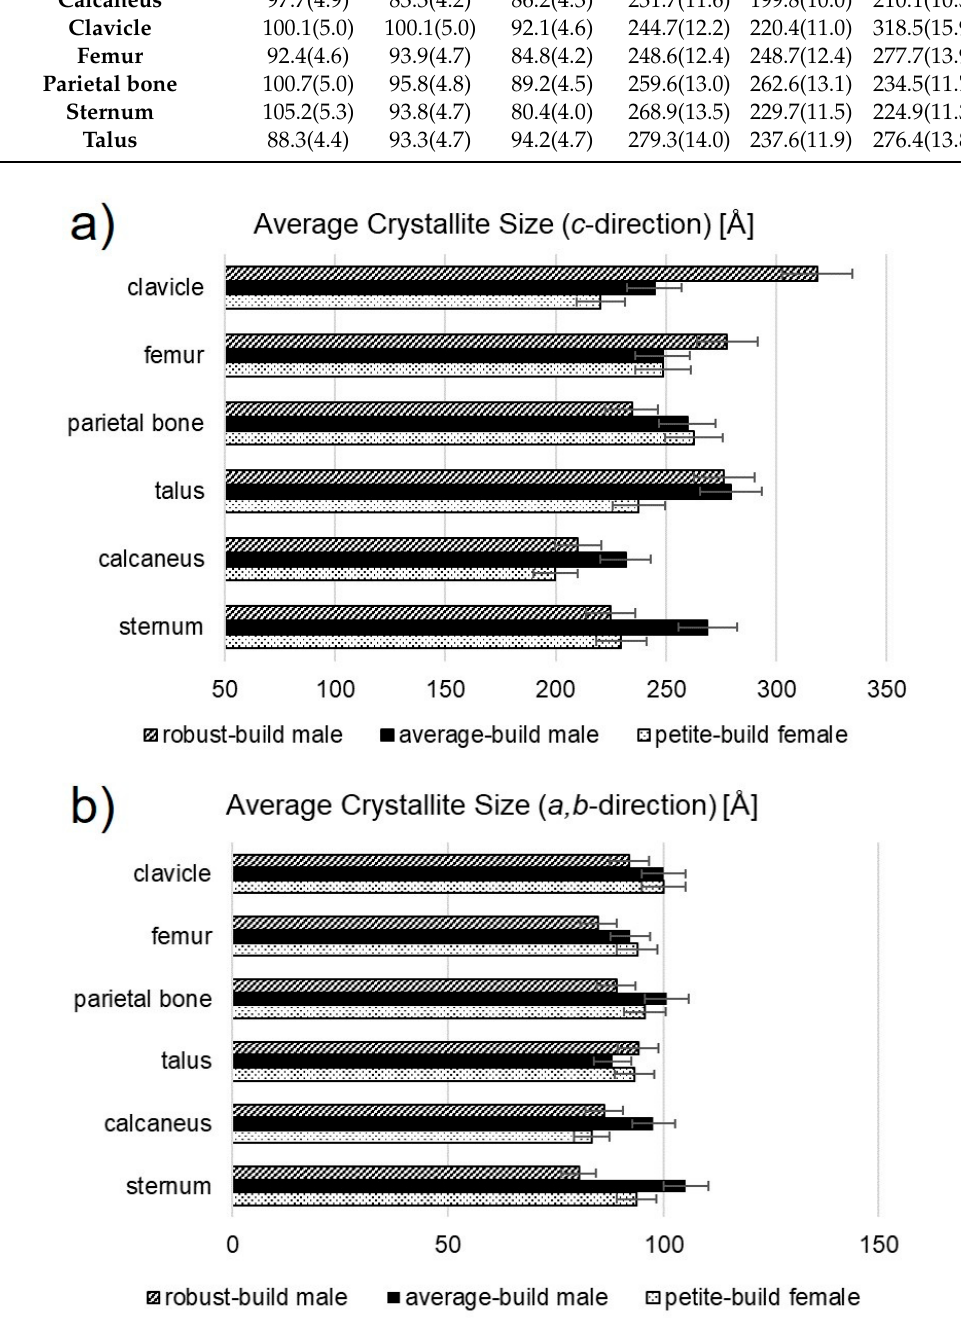
Figure 4. Average crystallite size of human bone bioapatite determined from the Rietveld refinement of XRPD data from human bone. Average crystallite size appeared elongated in the ( a ) c -direction compared to the ( b ) a,b -direction.